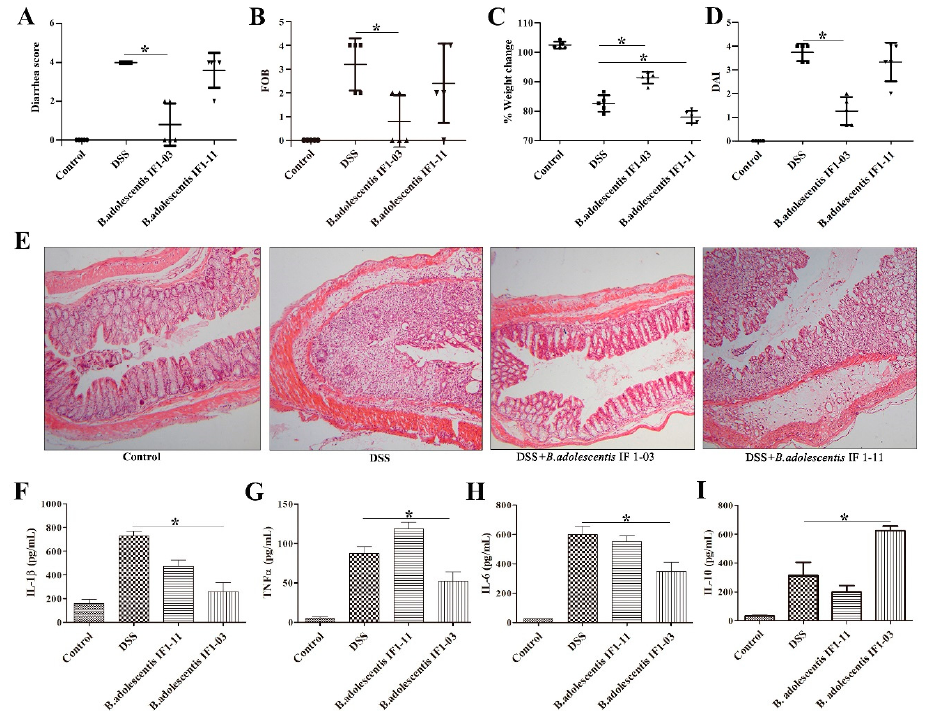
Figure 3. Effect of two bifidobacterial strains on DSS-colitis C57BL/6 mice. ( A ) Diarrhea, ( B ) bloody feces, tested by fecal occult blood (FOB) test kit, ( C ) weight variation between day 9 (oral DSS administration) and day 16 (death) and ( D ) disease activity index (DAI) of the different mouse treatment groups. Dot plots are representative of 5 individual mice in each mouse group. ( E ) Representative histological appearance of colonic tissues of C57BL/6 mice in the different treatment groups. Histochemical micrograph was taken at 10 × 10 magnification. ( F ) IL-1 β , ( G ) TNF- α , ( H ) IL-6 and ( I ) IL-10 secretion by colonic lamina propria cells of different mouse groups. C57BL/6 mouse treatment groups: Control, oral administration of skim milk only for 15 days; DSS, DSS-colitis model group, 6 days DSS ad libitum started on day 9; B. adolescentis IF1-11 and IF1-03 groups, oral administration of strain IF1-11 or IF1-03 for 15 days, plus 6 days DSS ad libitum started on day 9 for protection against DSS-colitis, respectively. Data are shown as mean ± SD for three independent experiments, significant difference between indicated groups means by one-way ANOVA (* p < 0.05). IL-1 β : Interleukin 1 β